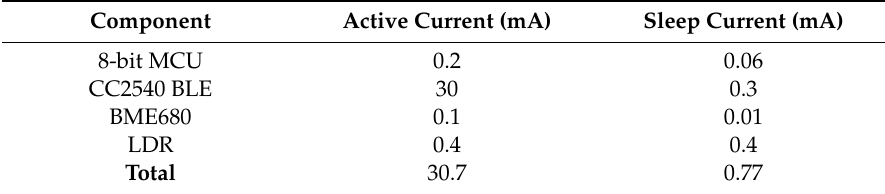
Table 2. Current consumption in indoor environmental monitoring system.